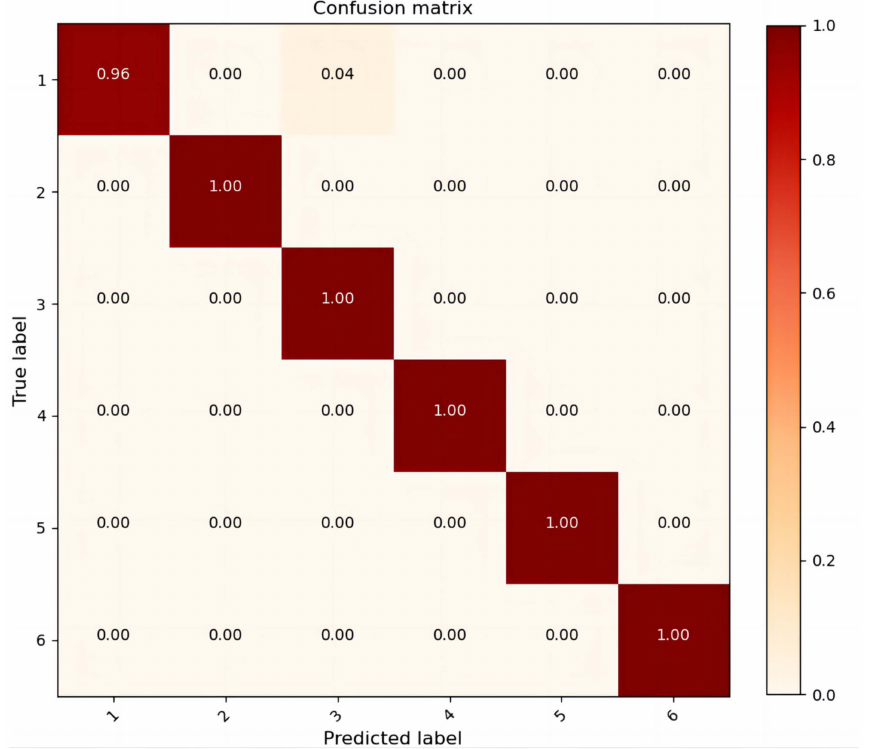
Figure 12. Confusion